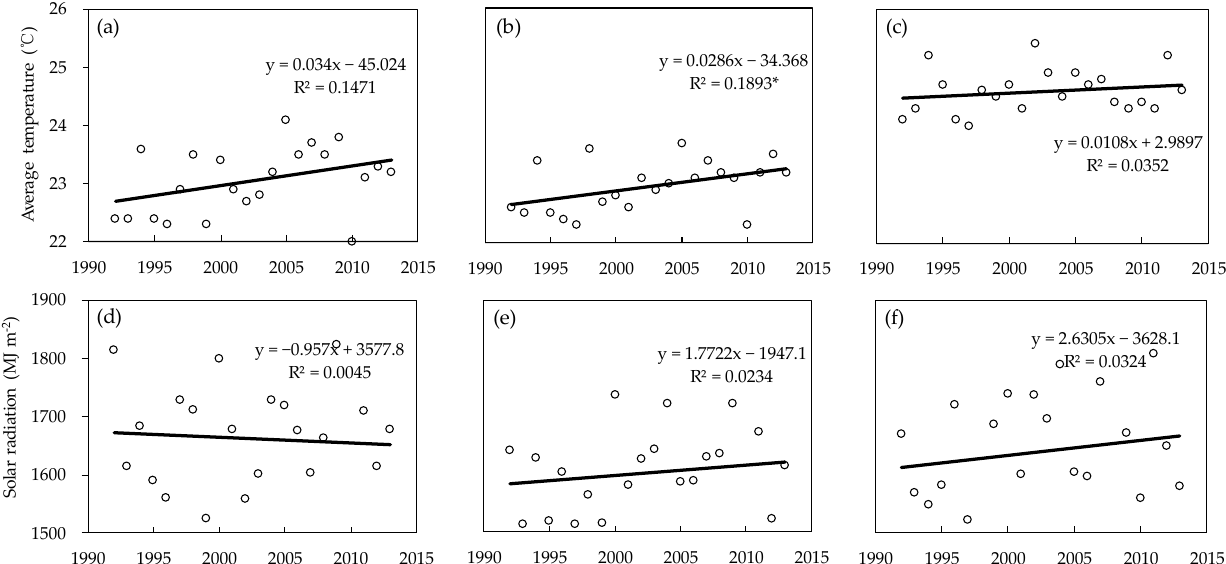
Figure 2. Trends in average temperature ( a – c ) and solar radiation ( d – f ) of the early rice growth period in the three climatic zones. ( a , d ), ( b , e ), and ( c , f ) indicate the northern subtropical zone (NST), middle subtropical zone (MST) and south subtropical zone (SST), respectively. * Significant at p <